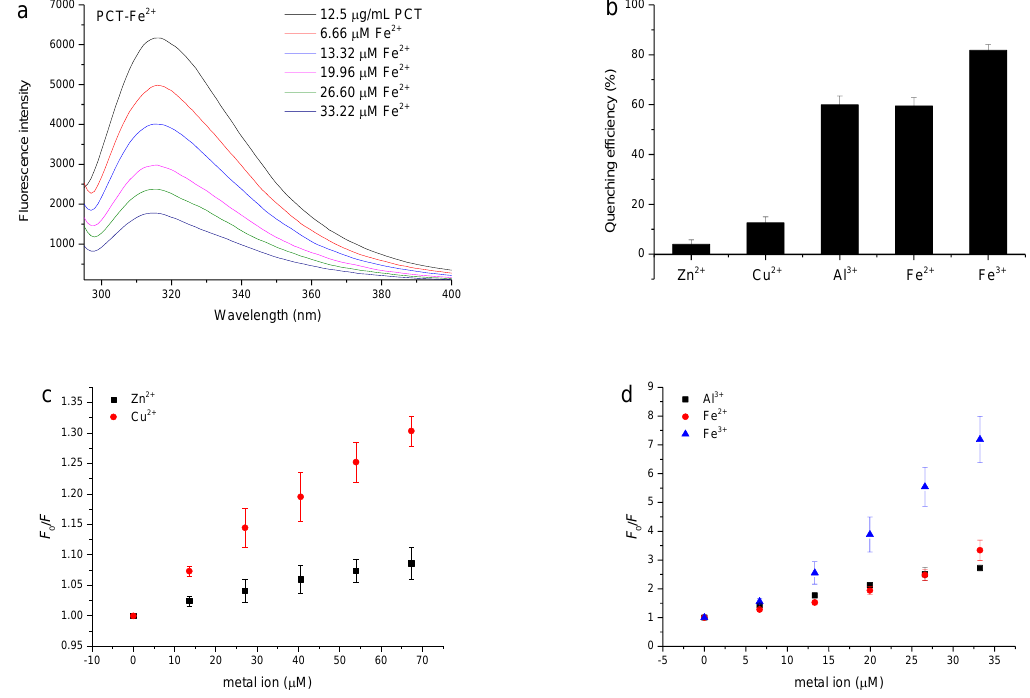
Figure 4. ( a ) Quenching of fluorescence intensity in 12.5 µg/mL polymeric condensed tannins from plum fruit (PCT) by Fe 2+ . Changes in the emission of the PCT were measured in a pH of 6.0, achieved with an acetate buffer; λ ex = 280 nm. ( b ) The quenching efficiencies of 26.60 µM Zn 2+ , Cu 2+ , Al 3+ , Fe 2+ , and Fe 3+ on the PCT were compared. The quenching efficiency was obtained by plotting [( F 0 − F ) × 100/ F 0 ] versus the metal ion concentration. ( c , d ) Stern – Volmer plots for PCT fluorescence quenching by Zn 2+ , Cu 2+ , Al 3+ , Fe 2+ , and Fe 3+ .